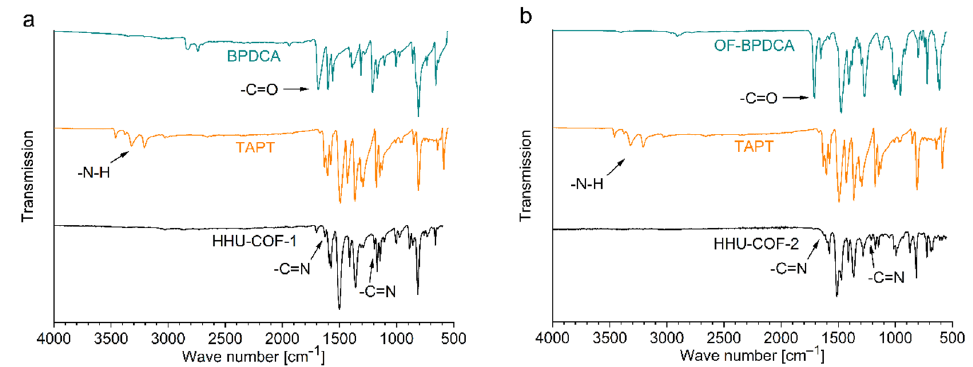
Figure 3. IR-spectra of ( a ) HHU-COF-1 and ( b ) HHU-COF-2 in comparison with the spectra of the educts.